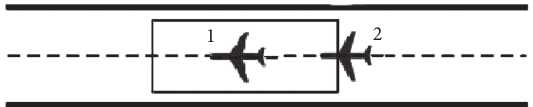
Figure 4: Rear-end conflict.